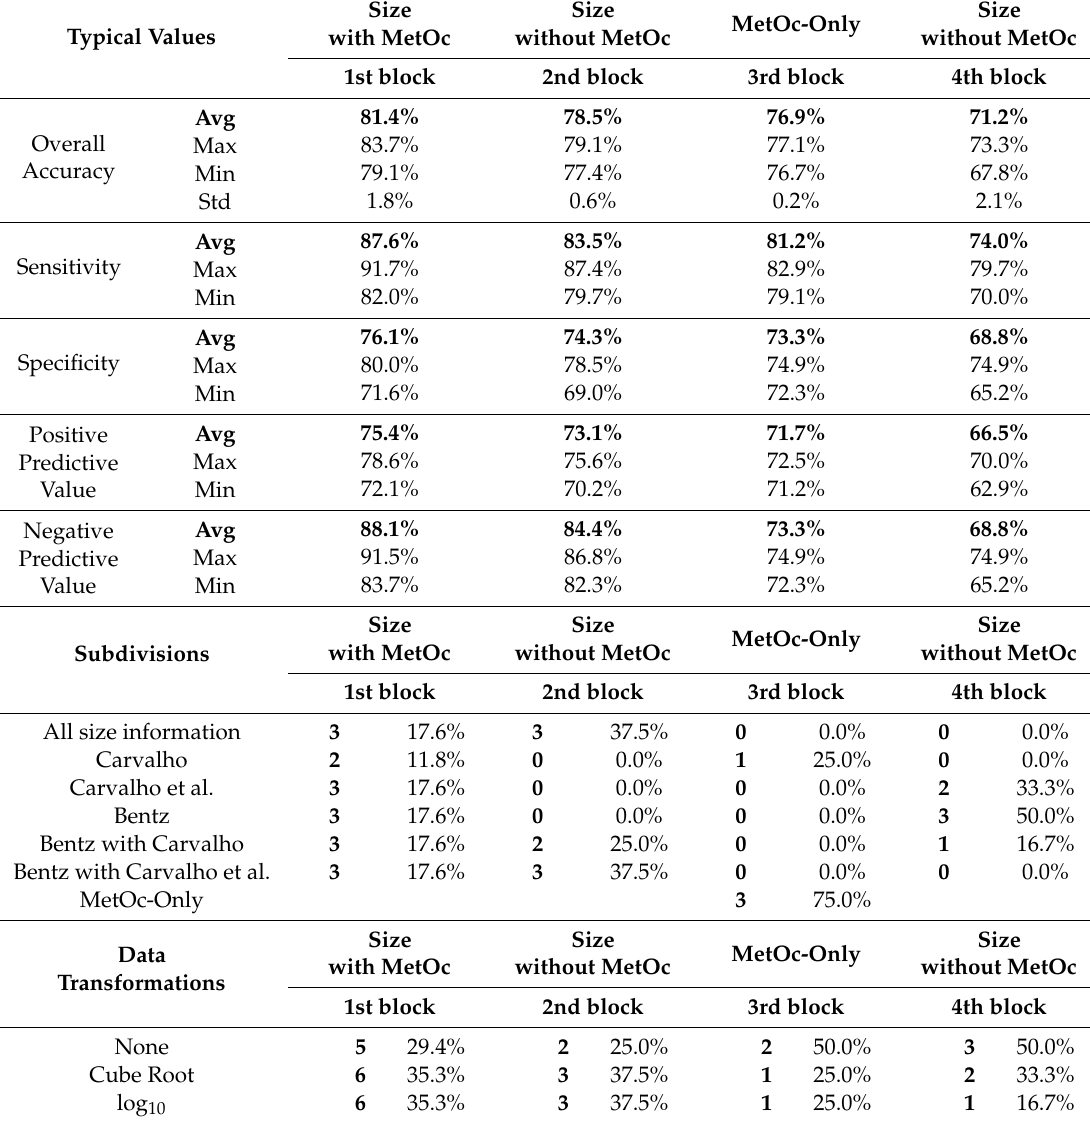
Table 7. Typical values of the four hierarchy blocks of Table 6: Average (Avg), Maximum (Max), Minimum (Min), and Standard Deviation